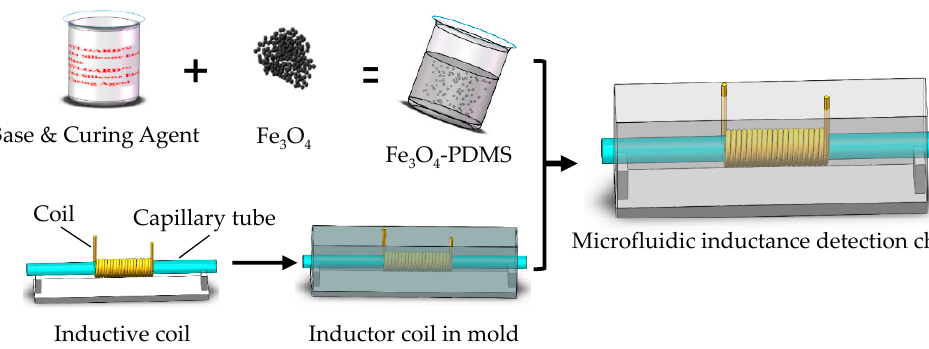
Figure 1. The fabrication of the 3-D solenoid coil with magnetic powder surrounded.